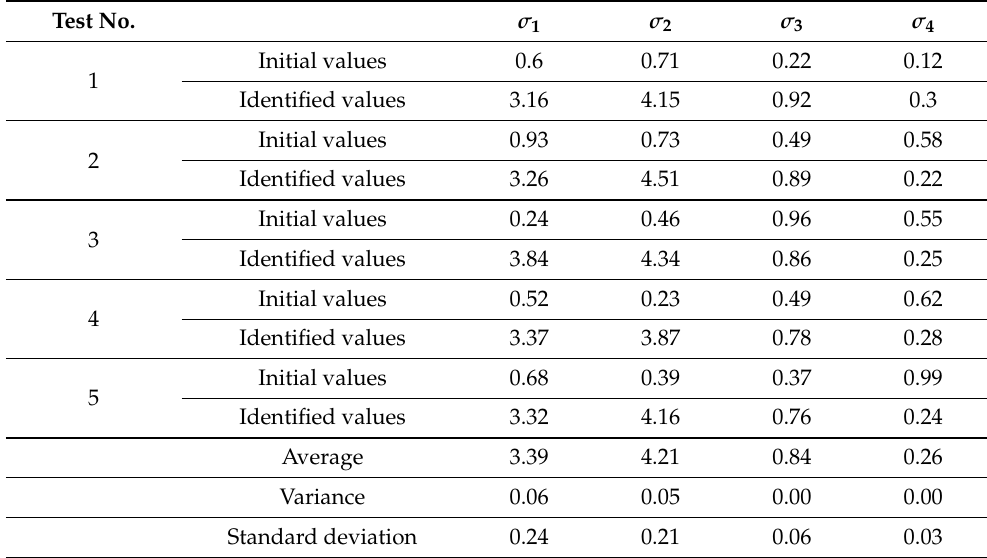
Figure 4. An example of the RLS identification process (test No. 1 from Table 2). Table 2. Example values of model parameters identified by the RLS method with random values of initial parameters.